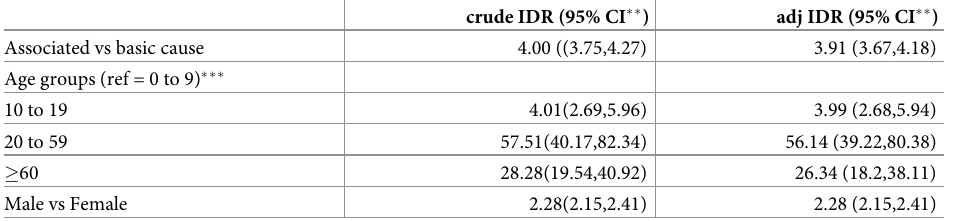
Table 2. Incidence Density Ratios (IDR) � for risk of cryptococcosis death in relation to basic or associated causes, age groups and gender, Brazil, 2000 to